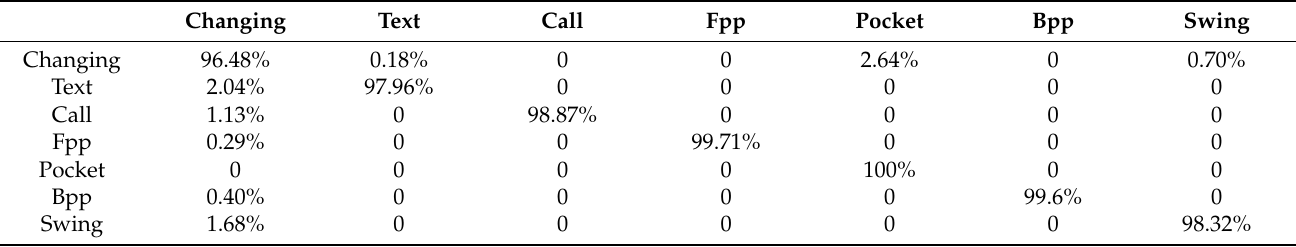
Table 9. Smartphone mode recognition results.